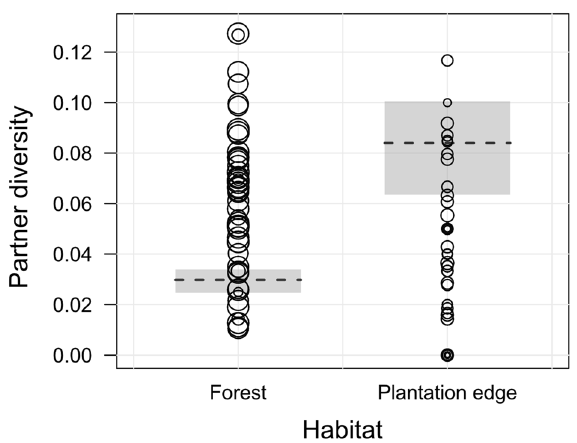
Figure 4. Effect of oil palm plantations on social partner diversity in Macaca nemestrina . Shown are individual scores of partner diversity, i.e. the number of different affiliative partners per point time scan, in the forest and at the plantation edge. The dashed lines show the fitted model and the shaded areas its 95% confidence interval, conditional on continuous control predictors being on their average, and based on age-sex class, group and time of the day manually dummy coded and then centred. For visual clarity, observation values were averaged per individual, with circle areas corresponding to respective observation hours per focal animal (Total N = 1206 focal observations of 50 individuals (36 of AMY , 14 of VOL ).